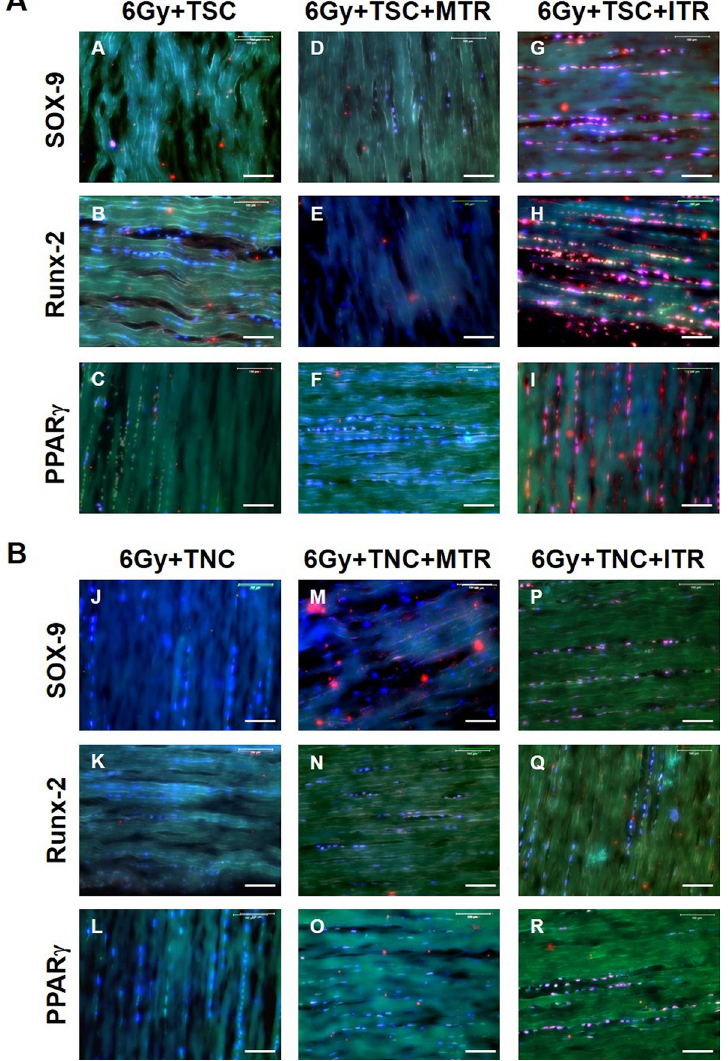
Fig 7. ITR induces non-tenocyte differentiation of TSCs in irradiated tendons determined by immunostaining. Top panel ( A ): A-C : TSCs-transplanted, irradiated tendons without running; D-F : TSCs-transplanted, irradiated tendon after MTR; G-I : TSCs-transplanted, irradiated tendon after ITR; Bottom panel ( B ): J-L : TNCs-transplanted, irradiated tendon without running; M-O : TNCs-transplanted, irradiated tendon after MTR; P-R : TNCs-transplanted, irradiated tendons after ITR. There is no positive staining in TSCs-transplanted, irradiated tendons ( A-C ) and TNCs- transplanted ( J-L ) without running for all three non-tenocyte markers including SOX-9 ( A, J ), Runx-2 ( B, K ), and PPAR γ ( C, L ). A few positively stained cells are found in TNCs-transplanted, irradiated tendons after ITR ( P-R ), and in TSCs-transplanted, irradiated tendons after MTR ( D-F ). However, a high percentage TSCs ( G-I ) are positively stained after ITR indicating the abundant presence of chondrocytes ( G ), osteocytes ( H ) and adipocytes ( I ) in mouse tendon tissues injected with TSCs that have undergone ITR. Three colors–green, red, and blue (DAPI) are merged in each of the images. Also, for each group sample, n = 6 tendons were used for analysis. Bars: 100 μ m.